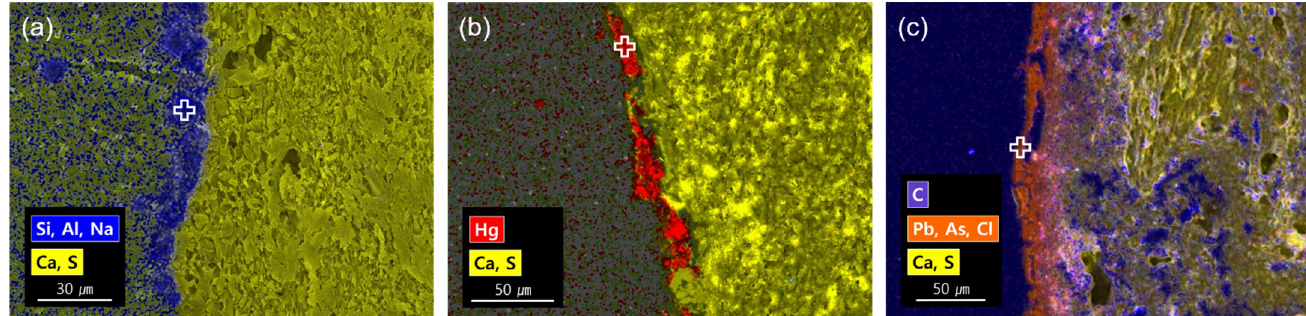
Figure 7. Overlaid elemental maps of ( a ) blue pigment, ( b ) red pigment, and ( c ) black pigment by SEM-EDS. The open crosses indicate the EDS analysis points in Table 1. Table 1. Results from SEM-EDS point analysis of the colored surface layer. Analyzing Point